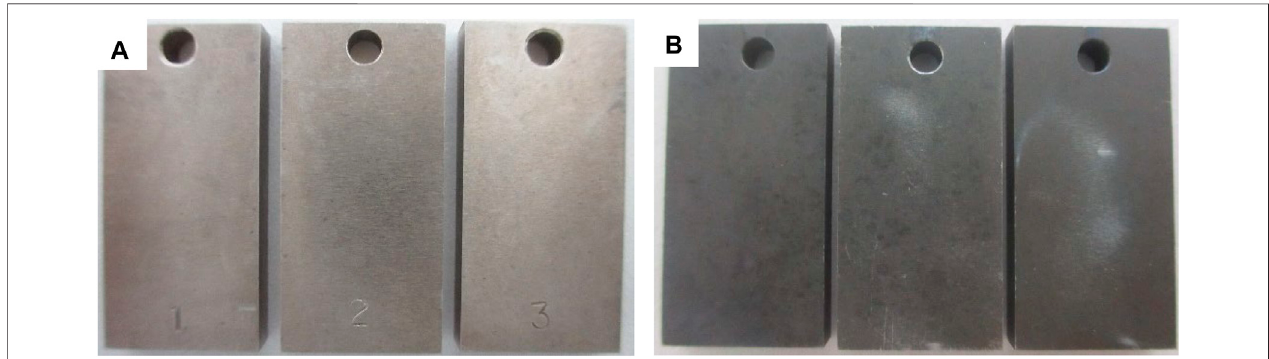
FIGURE 1 | Macro-morphology of 825 sample after the immersion tests at different temperatures: (A) no obvious corrosion product at 150 ° C, (B) black corrosion product at 230 ° C.